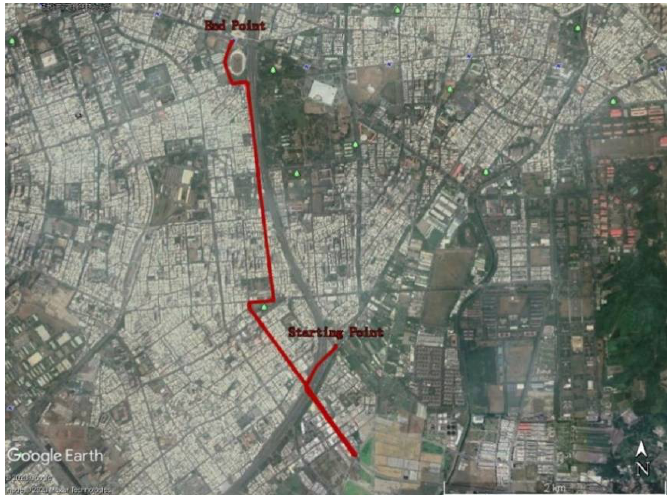
Figure 9. Urban test trajectory.